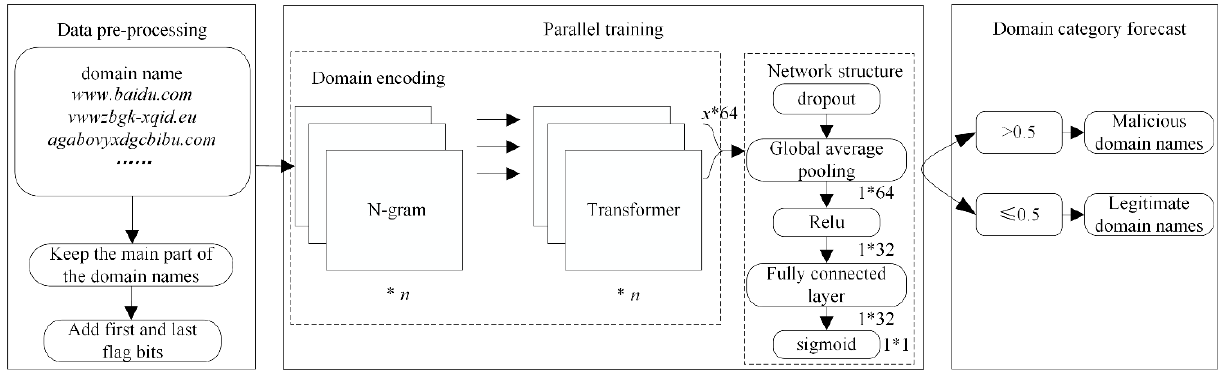
Figure 1. Parallel detection model. x is the number of features obtained. It describes the process by which the model detects malicious domains. The model is divided into three stages: data pre-processing, parallel training, and domain name category prediction.